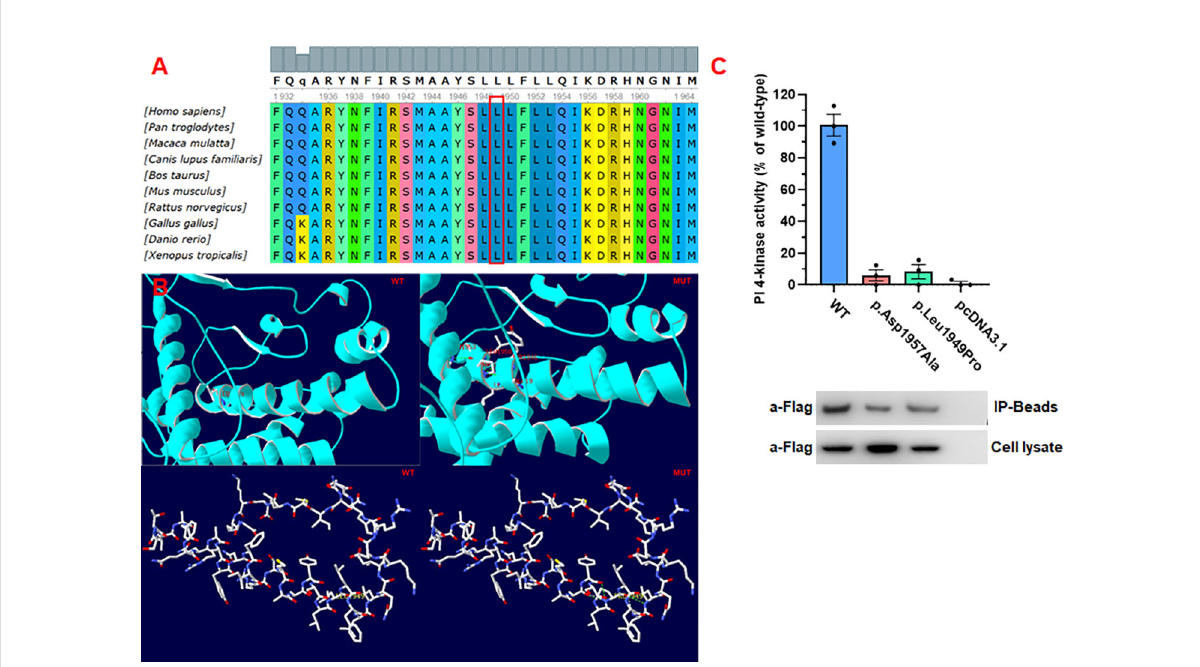
FIGURE 5 Pathogenicity of the missense mutations of PI4KA . (A) In silico analysis of p.Leu1949Pro in PI4KA shows the site p.Leu1949 highly conservative in different species. (B) 3D structure of wild type and mutant type of p.Leu1949Pro in PI4KA , and the mutation of p.Leu1949Pro changes the side strand structure and H-bond. (C) Functional studies of PI4KA c.5846T>C (p.Leu1949Pro) kinase